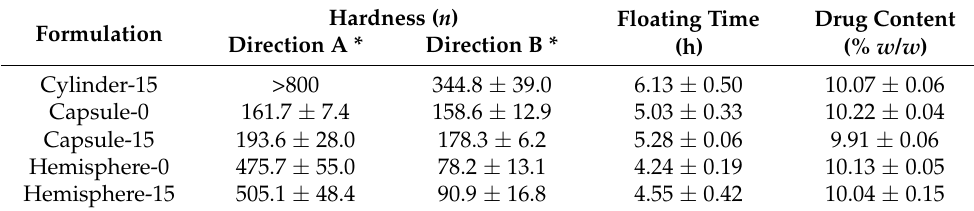
Table 2. In vitro characterization results of formulations.